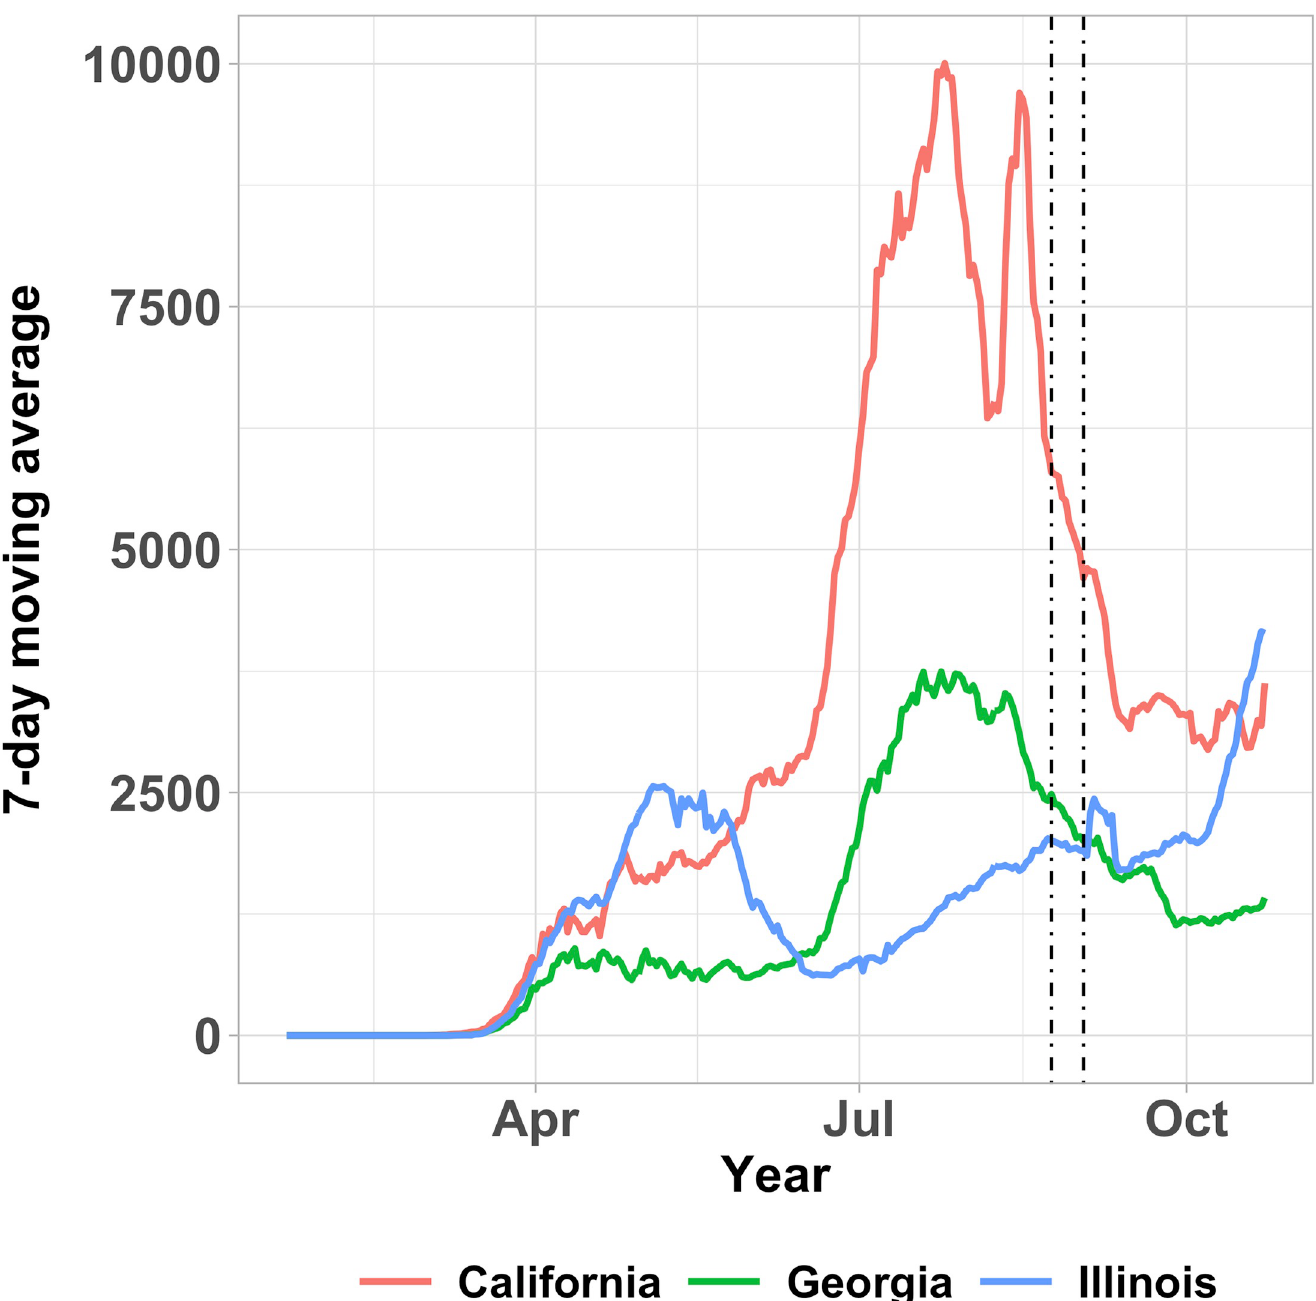
Fig 1. 7-day moving average of the number of cases across the three states. Dashed lines show the beginning and end of the survey period. Data source: https:// covid.cdc.gov/covid-data-tracker.